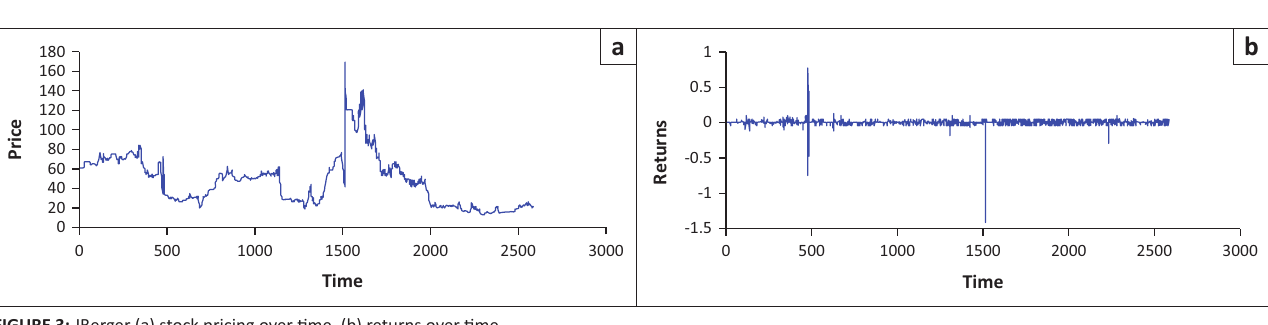
FIGURE 2: Oando (a) stock pricing over time, (b) returns over time.